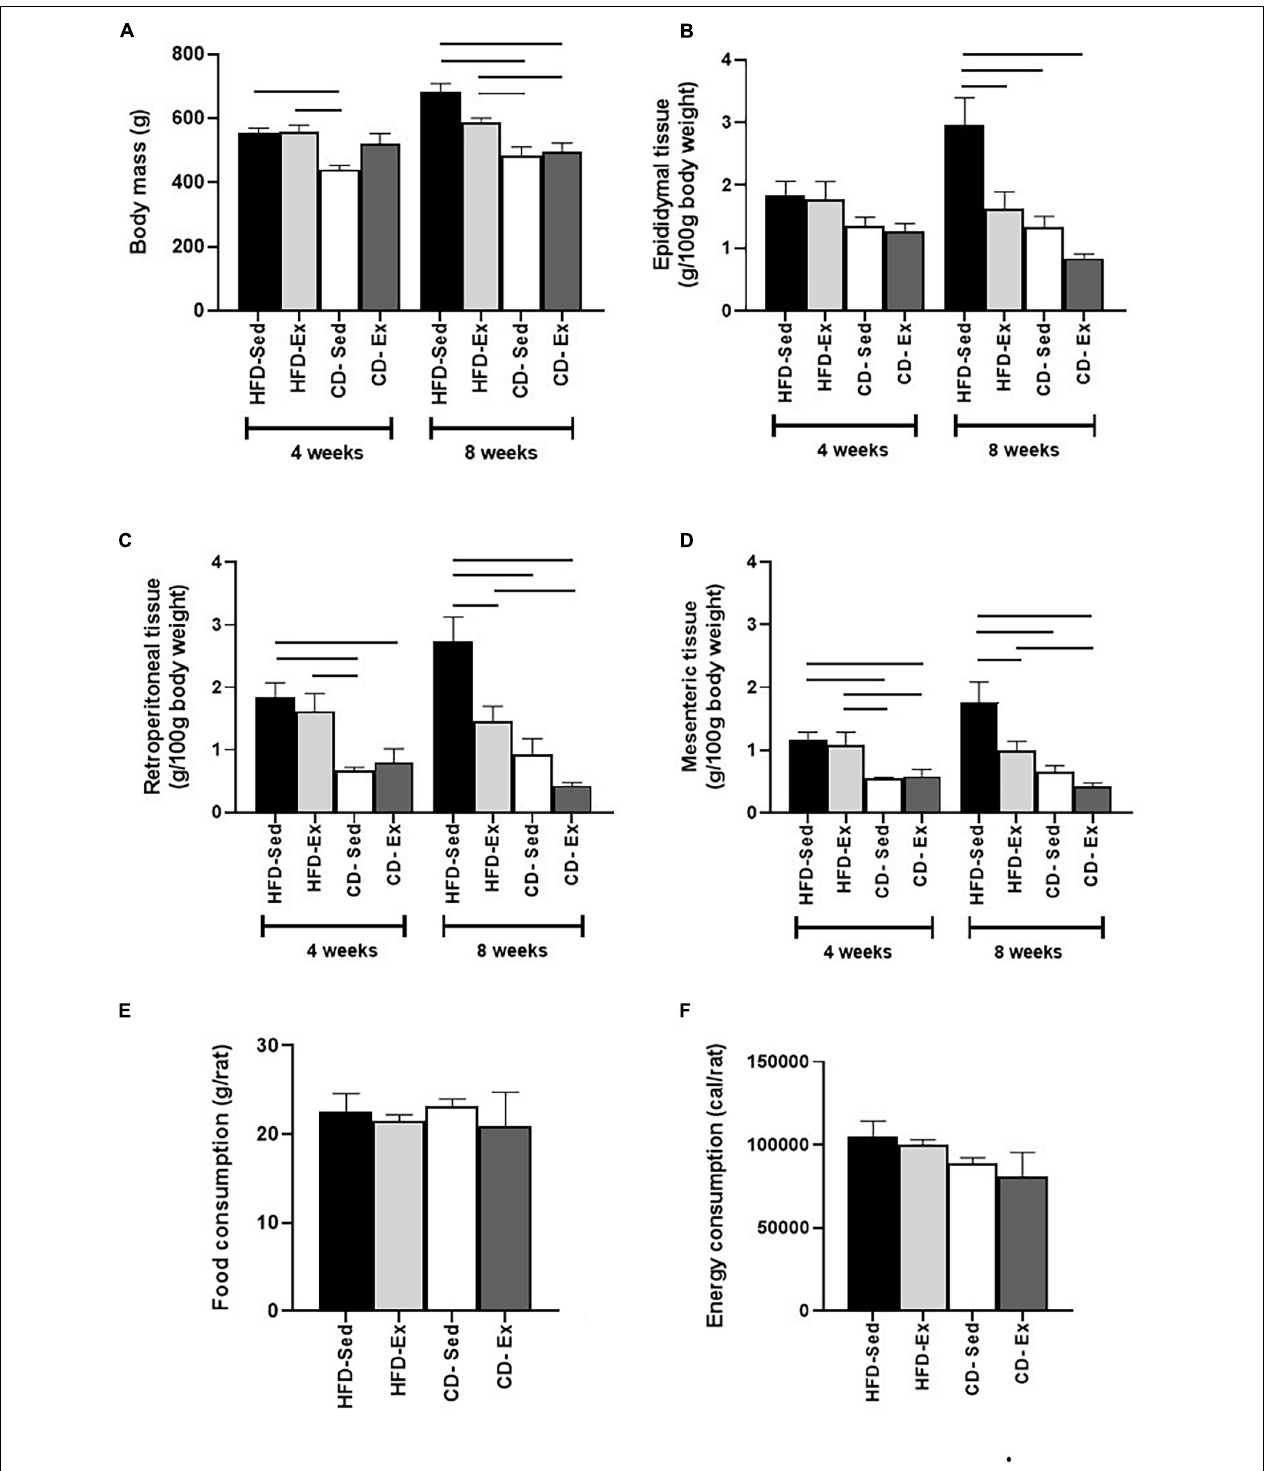
FIGURE 2 | Effects of diet and exercise on body mass and visceral depots. (A) Body mass was assessed by DXA every 4 weeks. (B) Epididymal adipose tissue of male Wistar rats. (C) Retroperitoneal adipose tissue of male Wistar rats. (D) Mesenteric adipose tissue of male Wistar rats. (E) Food consumption of Wistar rats after 8 weeks of intervention. (F) Energy consumption of Wistar rats after 8 weeks of intervention. HFD-Ex: high-fat diet and exercise; HFD-Sed: sedentary high-fat diet; CD-Ex: chow diet and exercise; CD-Sed: sedentary chow diet. The bars represent the significant differences between the groups indicated. Results are means ± SEM ( p <